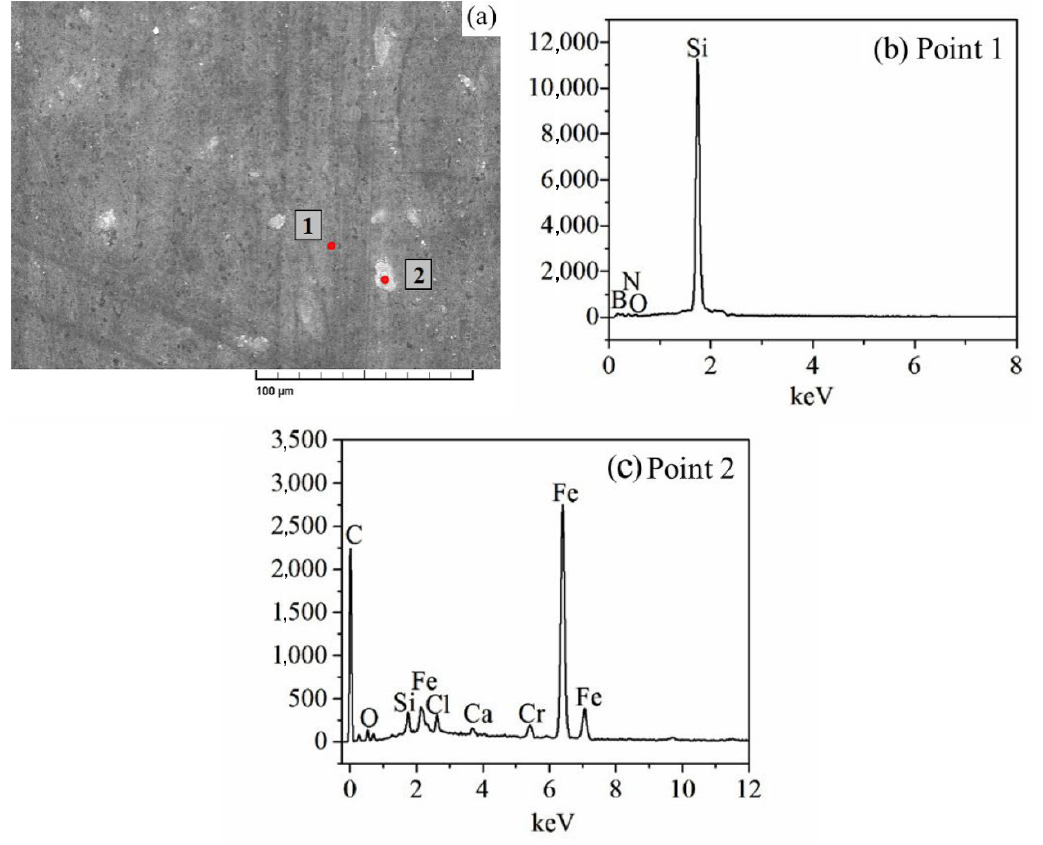
Figure 6. SEM image and EDS (Energy Dispersive Spectroscopy) results of the worn surface of the SN10 pin with seawater lubrication. SEM image of the worn surface of the SN10 pin with seawater lubrication ( a ), EDS results of the worn surface of the SN10 pin with seawater lubrication ( b , c ).